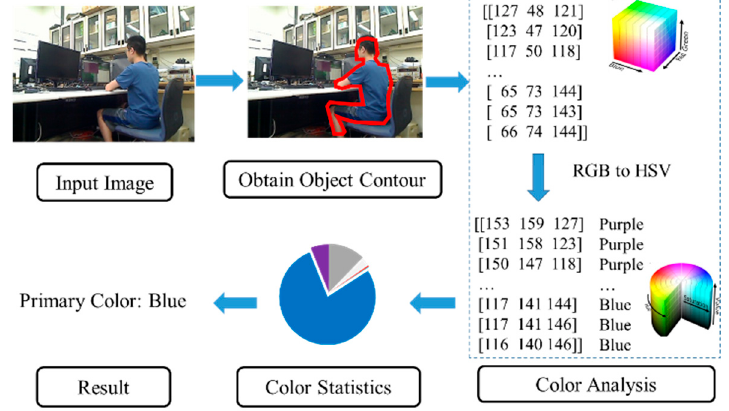
Figure 13. Overview of the object recognition process.